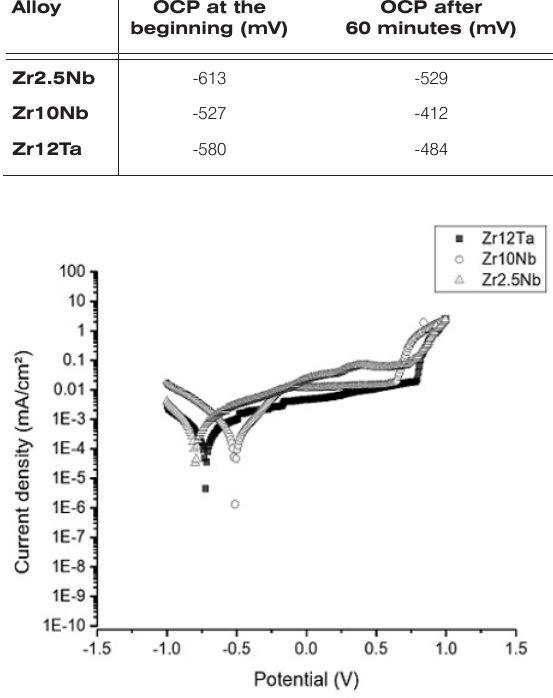
Figure 2. Tafel plots for Zr2.5Nb, Zr10Nb, Zr12Ta in human female serum.